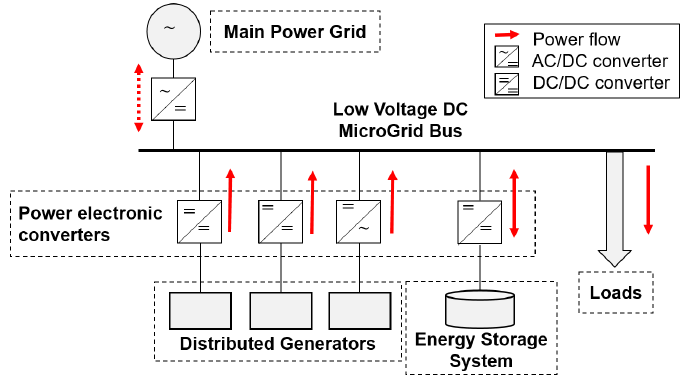
Figure 1. Architecture of a single bus DC microgrid (MG)